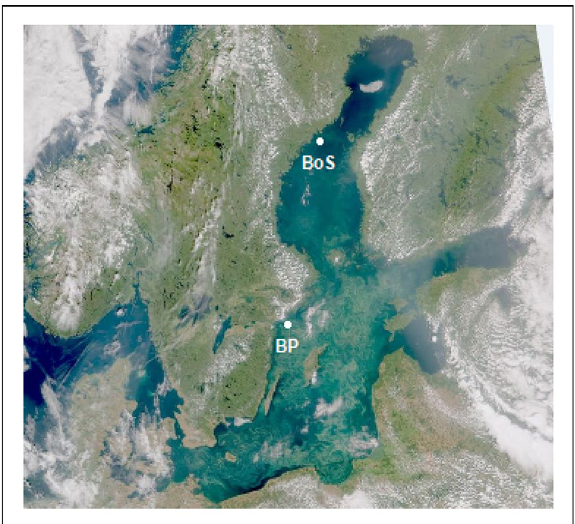
Figure 1. Satellite view of the Baltic Sea on July 25, 2019 (NOAA: Satellite SuomiNPP; data processed by SMHI), showing cyanobacterial blooms covering a great part of the Baltic Proper. White dots represent collection sites for Monoporeia affinis used in the common-garden experiment in the Baltic Proper (BP: stn. Grund utsjö) and northern Bothnian Sea (BoS: stn. N21). The experimental sediment, diatoms, and cyanobacteria were collected close to the BP station (see text for differences in characteristics among